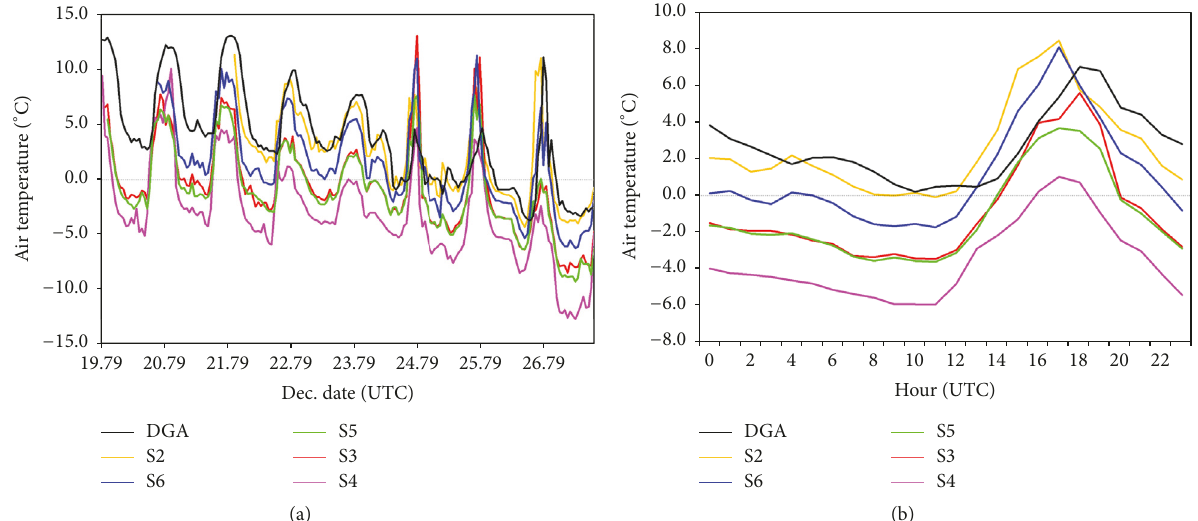
Figure 4: (a) 2-m surface air temperature profiles at the DGA automatic weather station and Tinytag sensors S2, S6, S5, S3, and S4 (moving progressively up the glacier), based on data recorded each hour (19–26 March 2015); and (b) mean daily 2-m surface air temperature